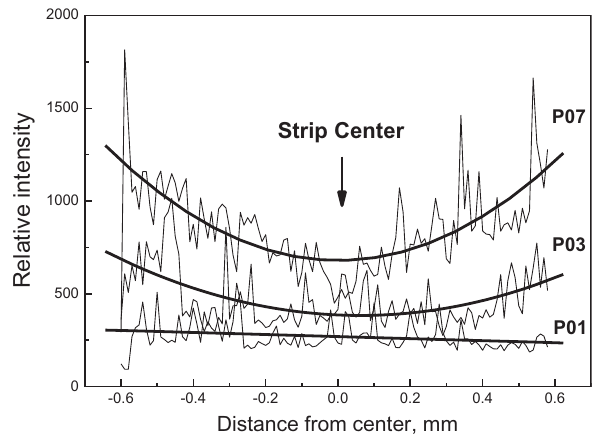
Figure 2: Phosphorus distribution along the thickness direction of three strip cast steels with carbon content of 0.16 wt.% and different phosphorus contents of P07-0.7 wt.%, P03-0.3 wt.%, and P01-0.1 wt.% [6].